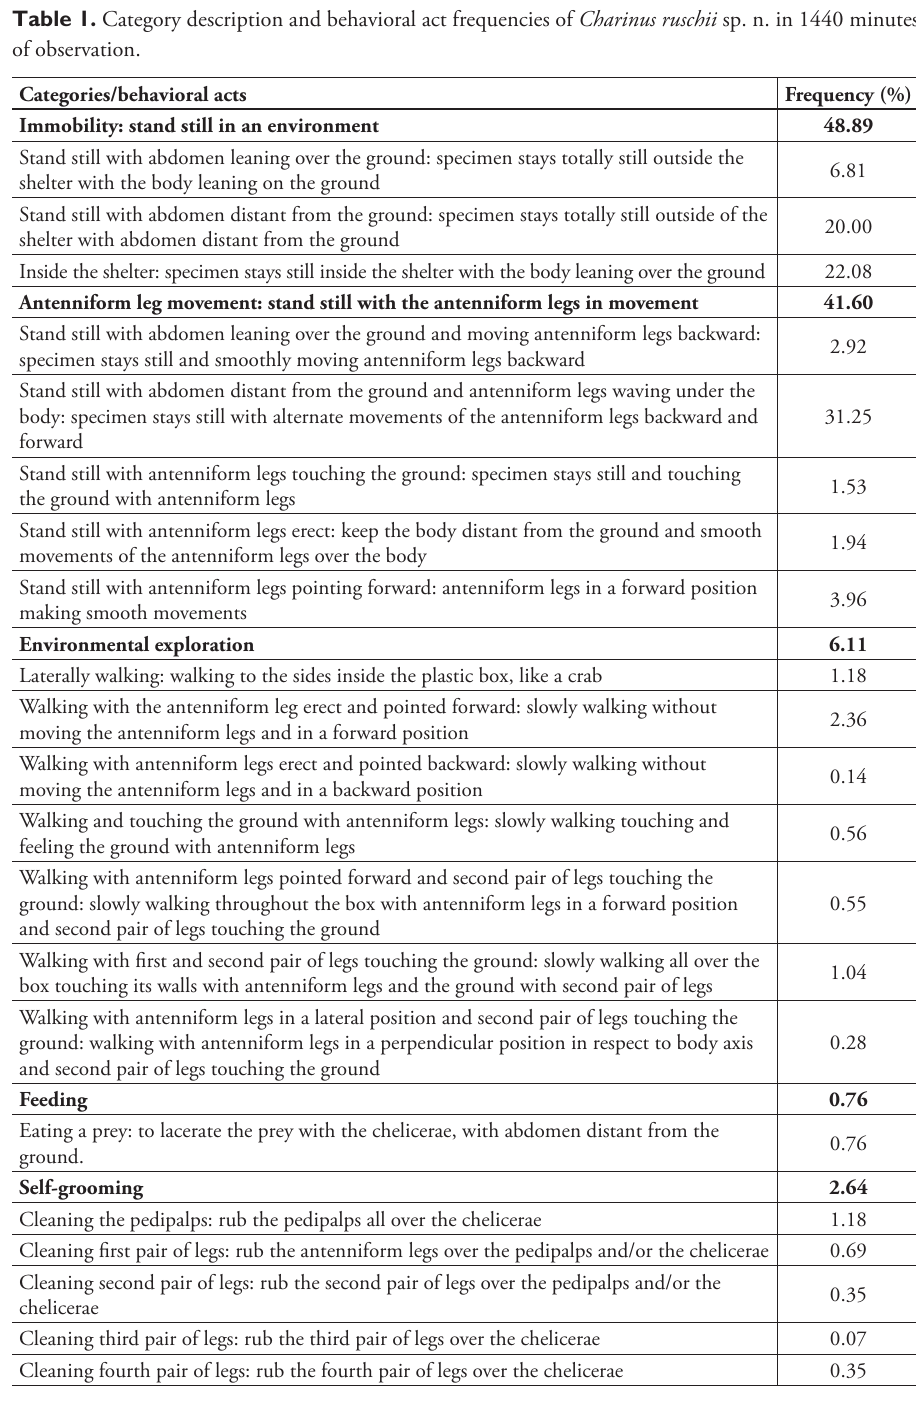
Table 1. Category description and behavioral act frequencies of Charinus ruschii sp. n. in 1440 minutes of